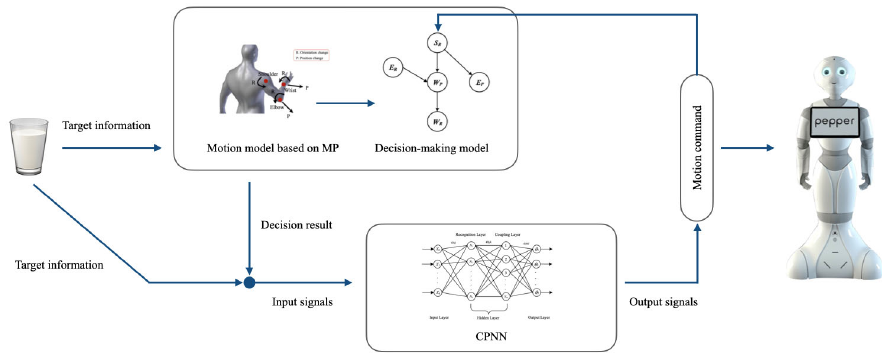
Figure 1. The structure of the IHMP to generate human-like movements.